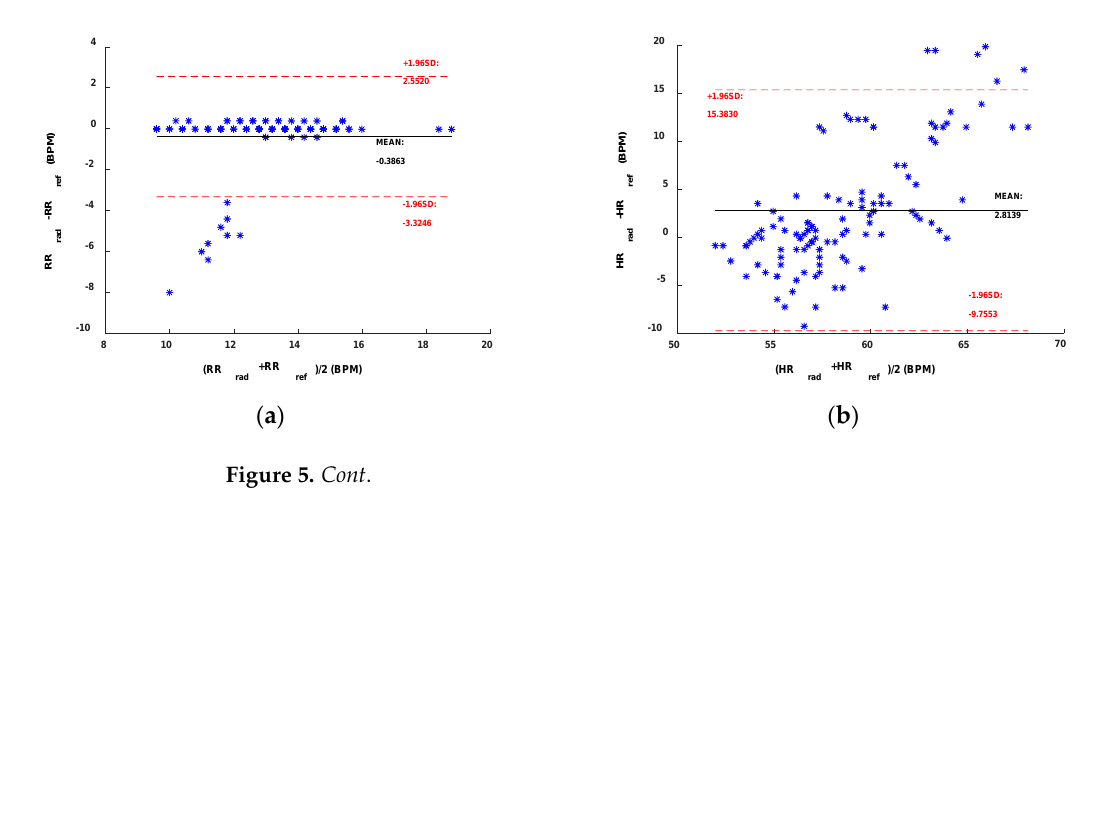
Figure 4. Bland–Altman comparisons of the references and the sub-10 GHz radar. ( a ) RR and (b ) HR with the AC Coupling method. ( c ) RR and ( d ) HR with the linear demodulation method.